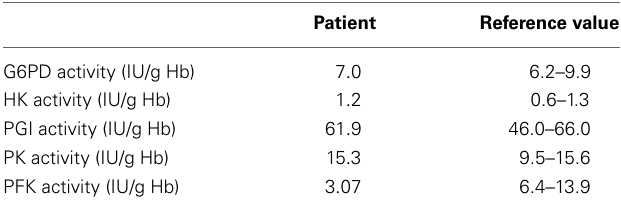
Table 1 | Red blood cell enzyme activity measurements.